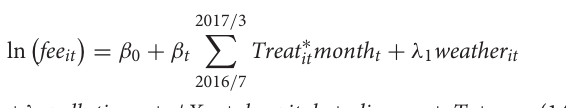
regression equation is given by Equation